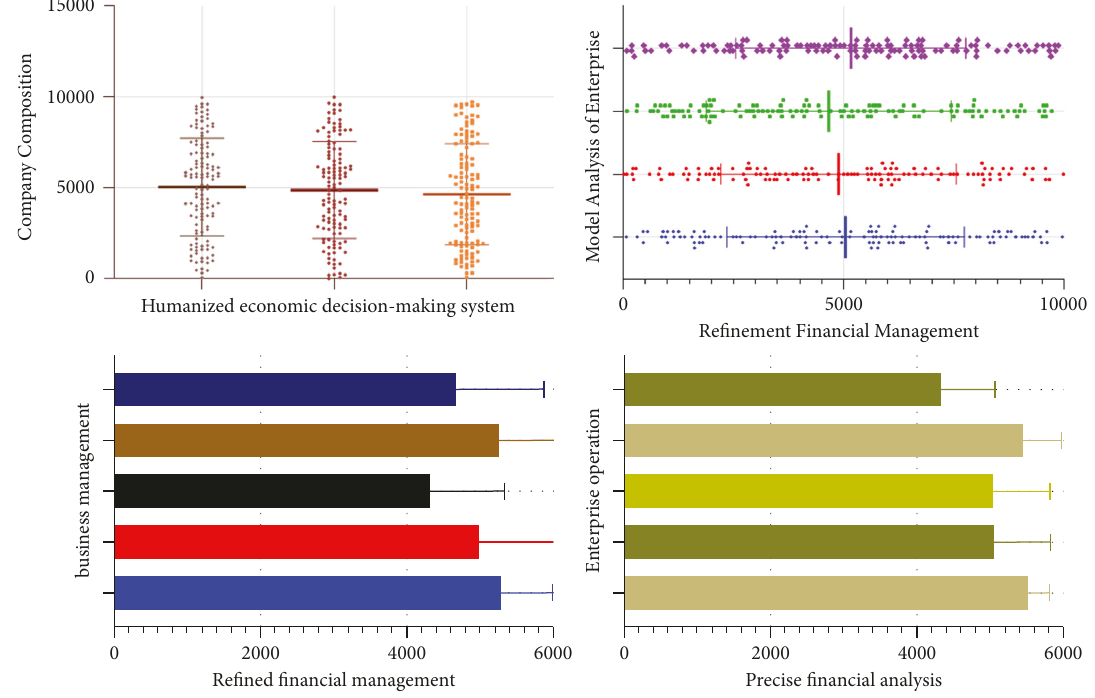
Figure 6: The model analysis of enterprise refinement financial management.